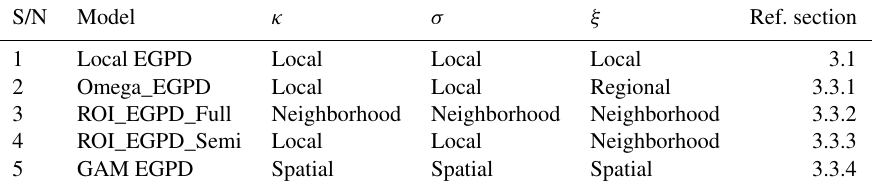
Table 1. Summary of the regional models that are compared in this study. The first model is the local EGPD model, the next three models are based on regional homogeneity, and the last model is a spatial method based on GAM. The second column gives the name of the model. The next three columns are the parameters of the EGPD model and indicate whether the parameter is estimated locally (from the data of the station at hand only) or through regionalization. The last column gives a reference to the section where the method is described. S/N Model κ σ ξ Ref. section 1 Local EGPD Local Local Local 2 Omega_EGPD Local Local Regional 3 ROI_EGPD_Full Neighborhood